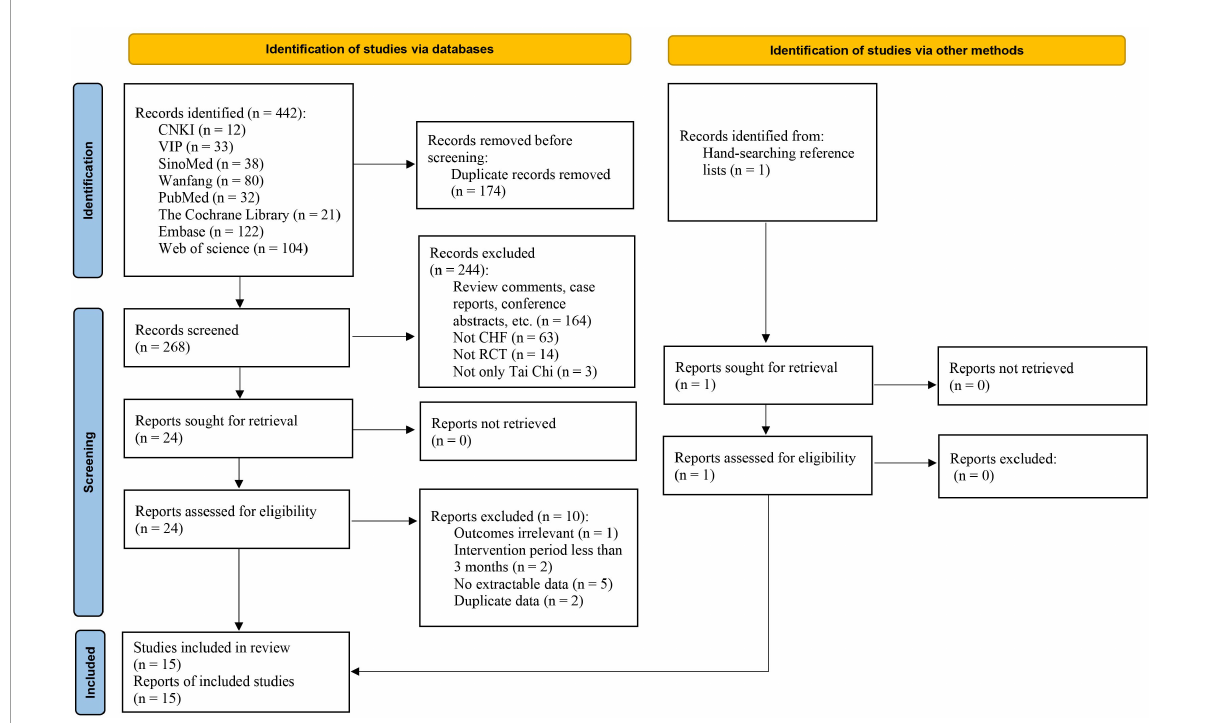
FIGURE1 Flow diagram of the study selection process. CHF, chronic heart failure; CNKI, China National Knowledge Infrastructure; RCT, randomized controlled trial; SinoMed, Chinese Biomedical Database; VIP, Chinese Scientific Journal Database (Chinese VIP